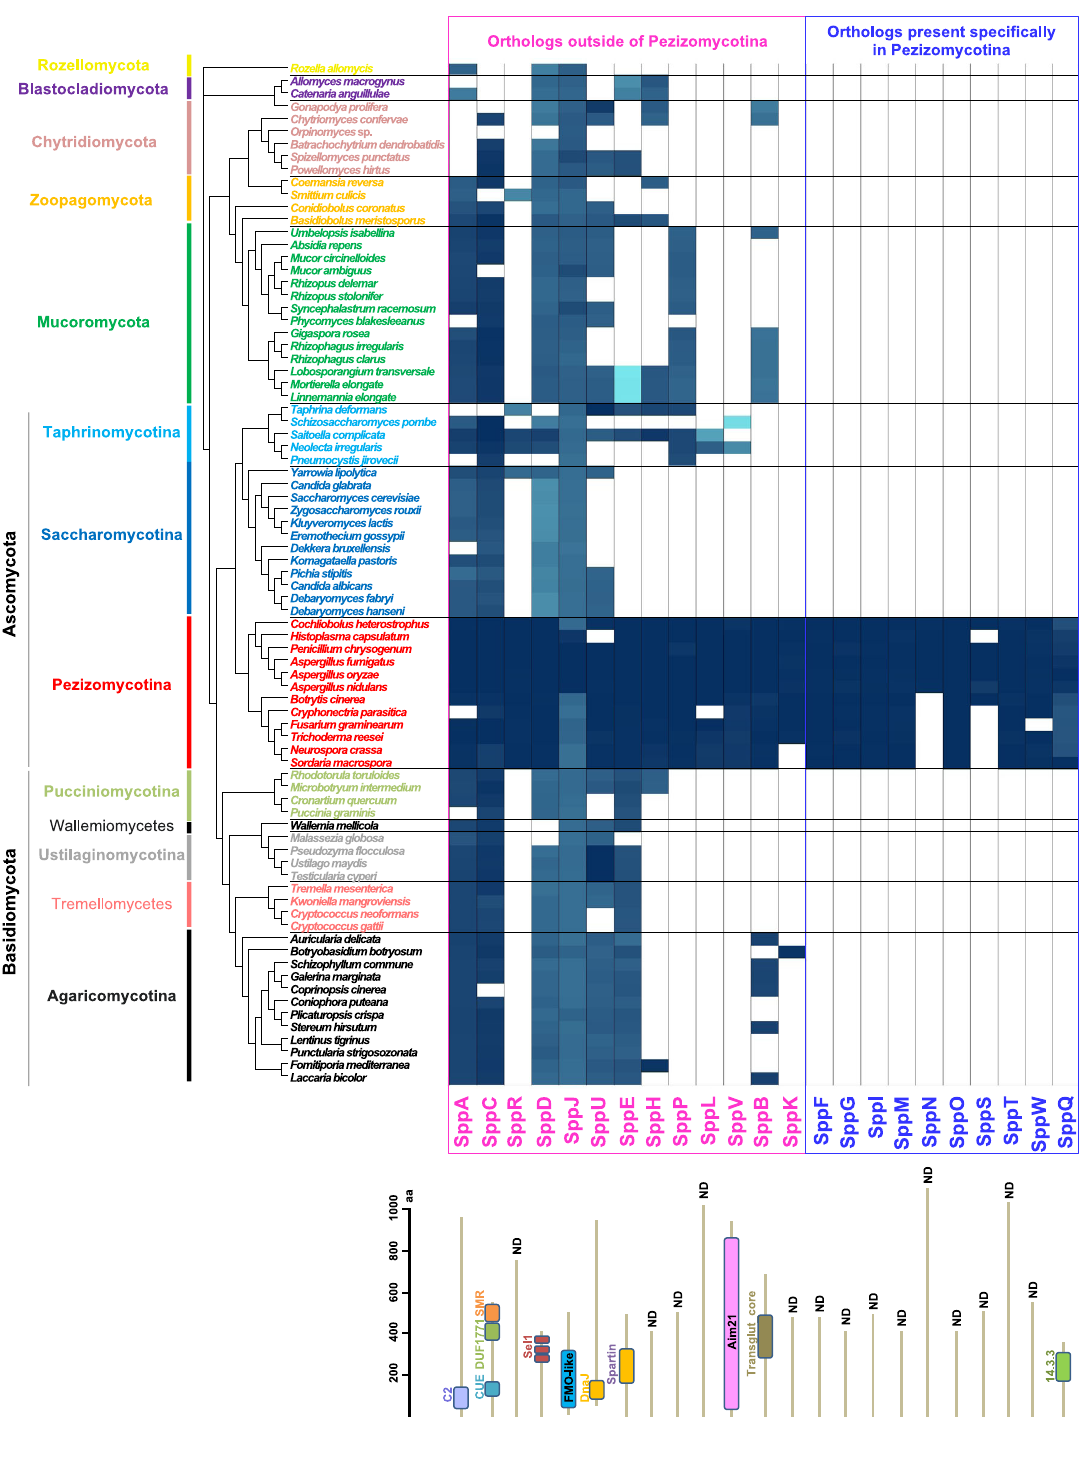
Fig. 7 | Orthologous relations and substitution rates of SPP proteins among fungal taxa. Amino-acid substitutions per site are shown in blue as a heat map. Filledand emptycolorsdenotethe presenceand absence of orthologous proteins, respectively, according to the results of OrthoFinder. The phylogenetic tree was